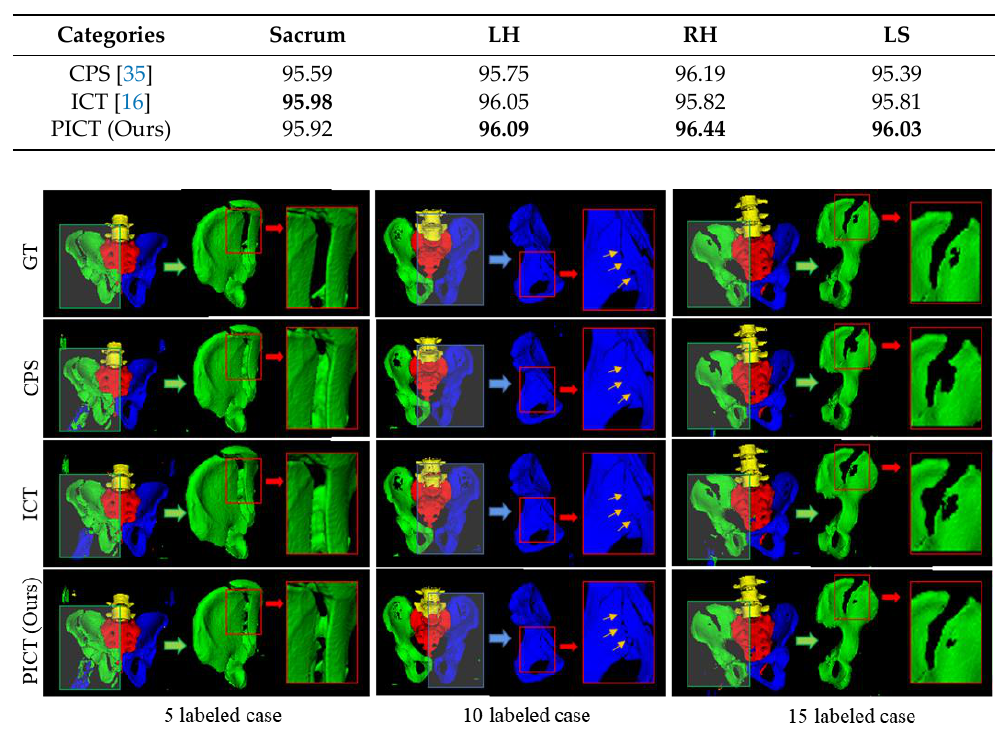
Figure 8. Representative cases of three methods on CTPelvic1k dataset. The green, blue, yellow, and red parts of the visual model represent the left hip bone, right hip bone, lumbar spine, and sacrum, respectively.